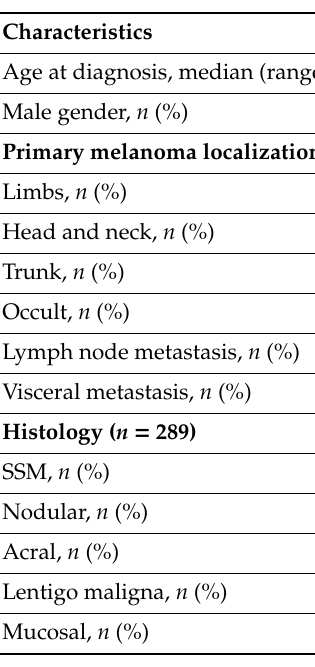
Table 1. Patient demographics and melanoma characteristics in the study